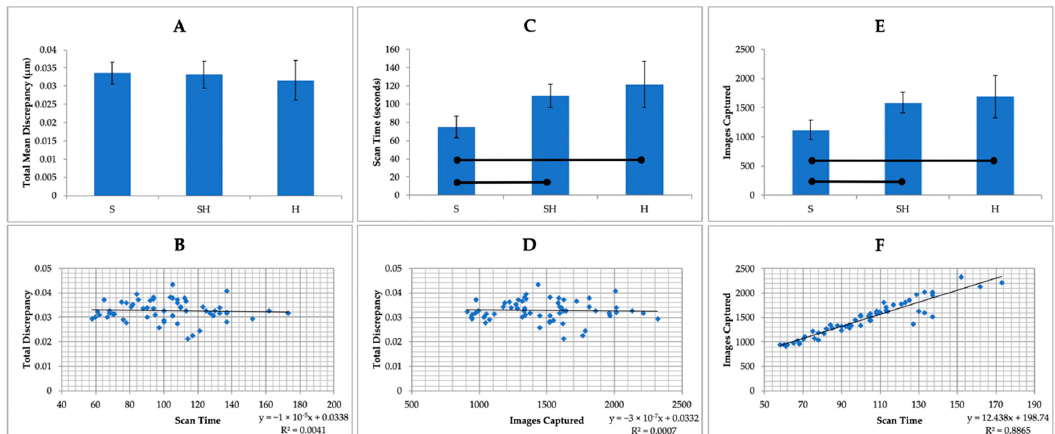
Figure 4. Comparison of total discrepancy, scan time, and number of images captured per scan between scan resolutions: standard resolution (SR), standard resolution with high resolution around the preparation margin (SHR), and high resolution (HR). Statistical analysis was performed using one-way analysis of variance followed by multiple comparisons using Dunnett’s T3 test. Pearson correlations were used to correlate total discrepancy with scan time and number of images captured. Horizontal bars show significant di ff erences ( p < 0.05). ( A ): total discrepancy by scan resolution: no statistically significant di ff erence was observed in the overall comparison ( p > 0.05). ( B ): no correlation was observed between total discrepancy and scan time. ( C ): a significant di ff erence was observed between